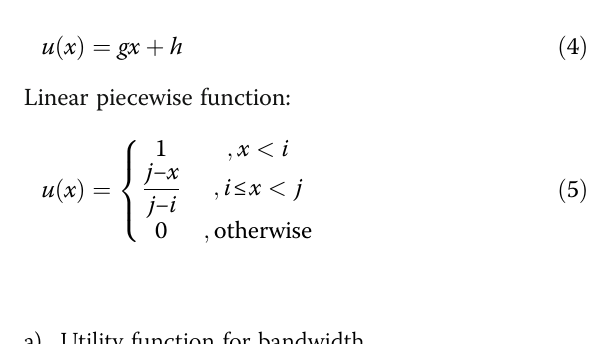
Fig. 7 Packet loss ratio utility function curve for voice, video, and data applications